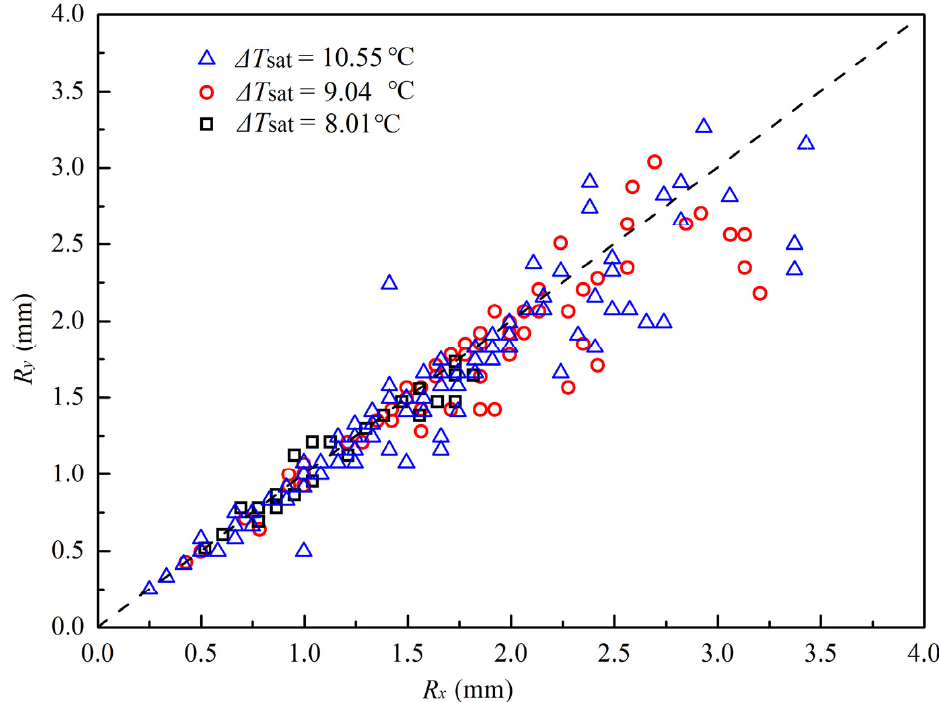
Figure 4. Bubble radial scale vs. axial scale.